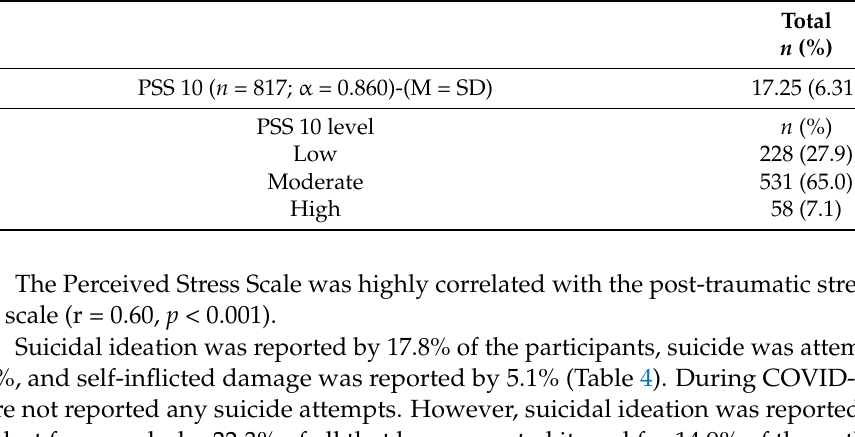
Table 3. Perceived stress during the first wave of